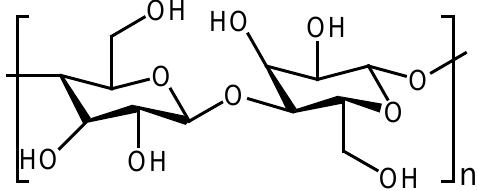
Figure 6. Chemical structure of cellulose.